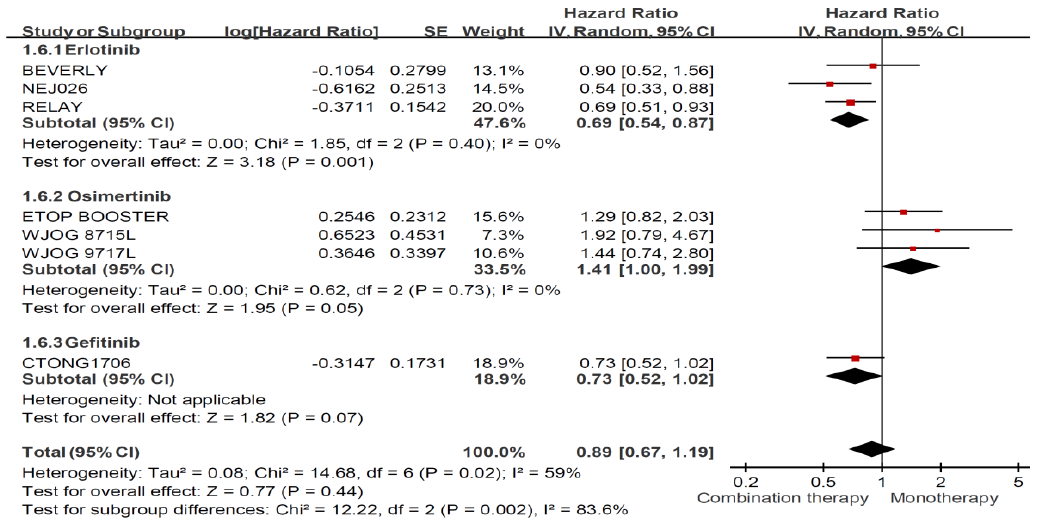
Figure 5. Forest plot and pooled hazard ratio for progression free survival (PFS) in the never smoker subgroup (Stratified by regimen).